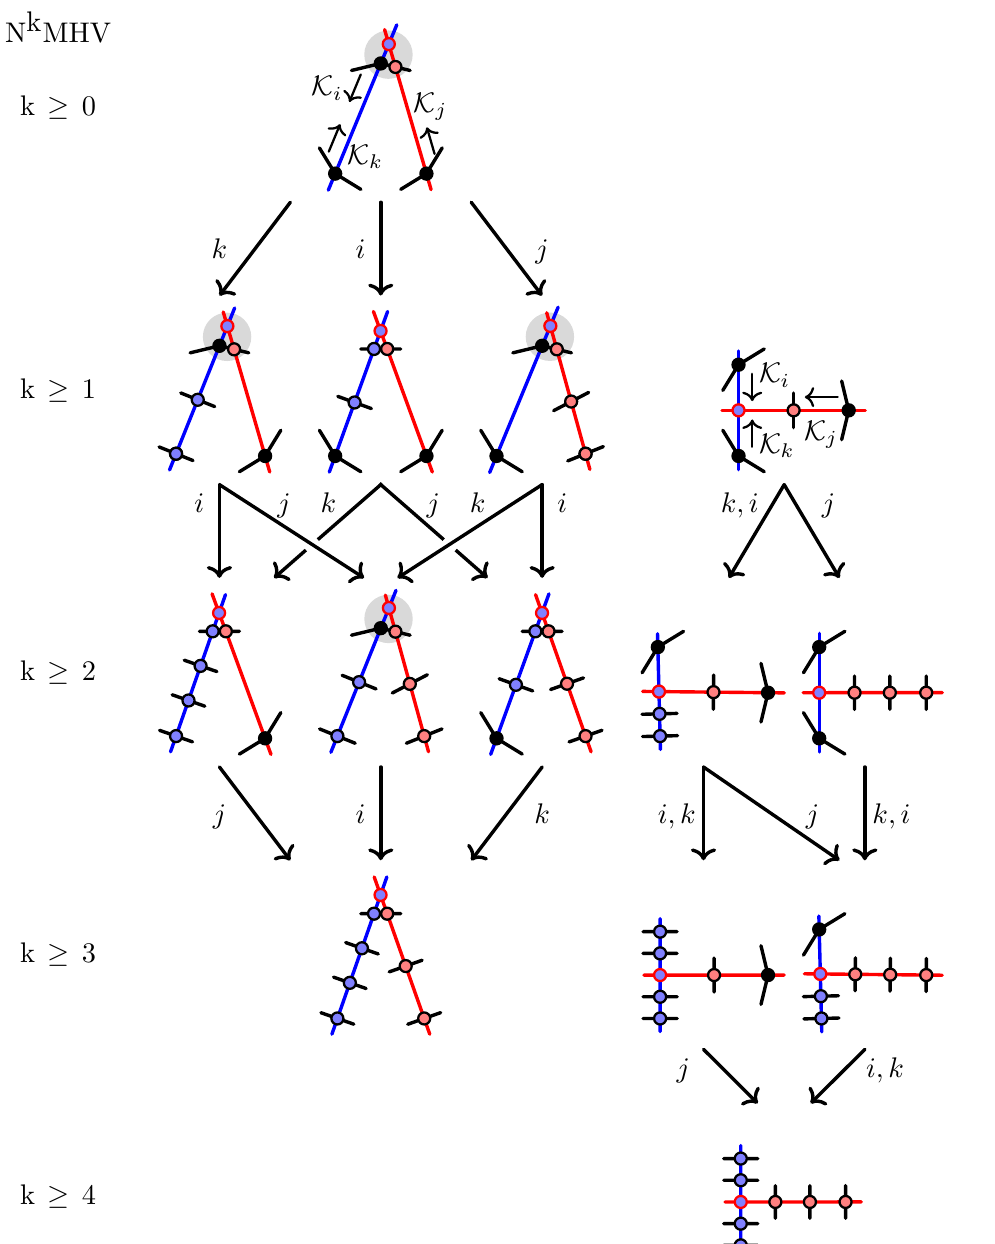
Figure 1 . The twistor diagrams depicting the 14 distinct maximal codimension boundaries of two-loop N k MHV amplituhedra. See the text for more